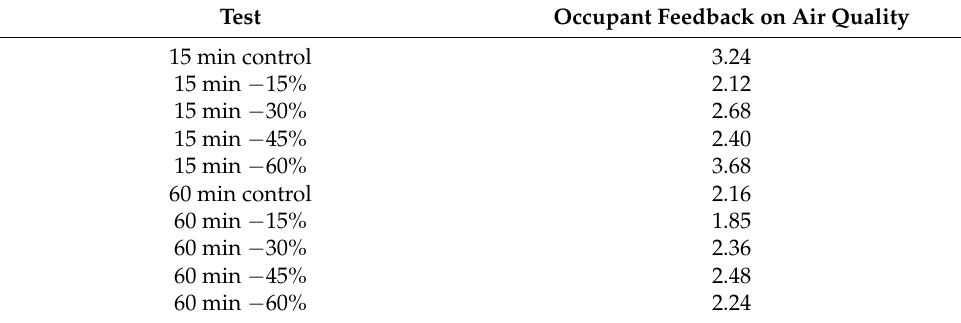
Table 5. Occupant feedback average for each test.